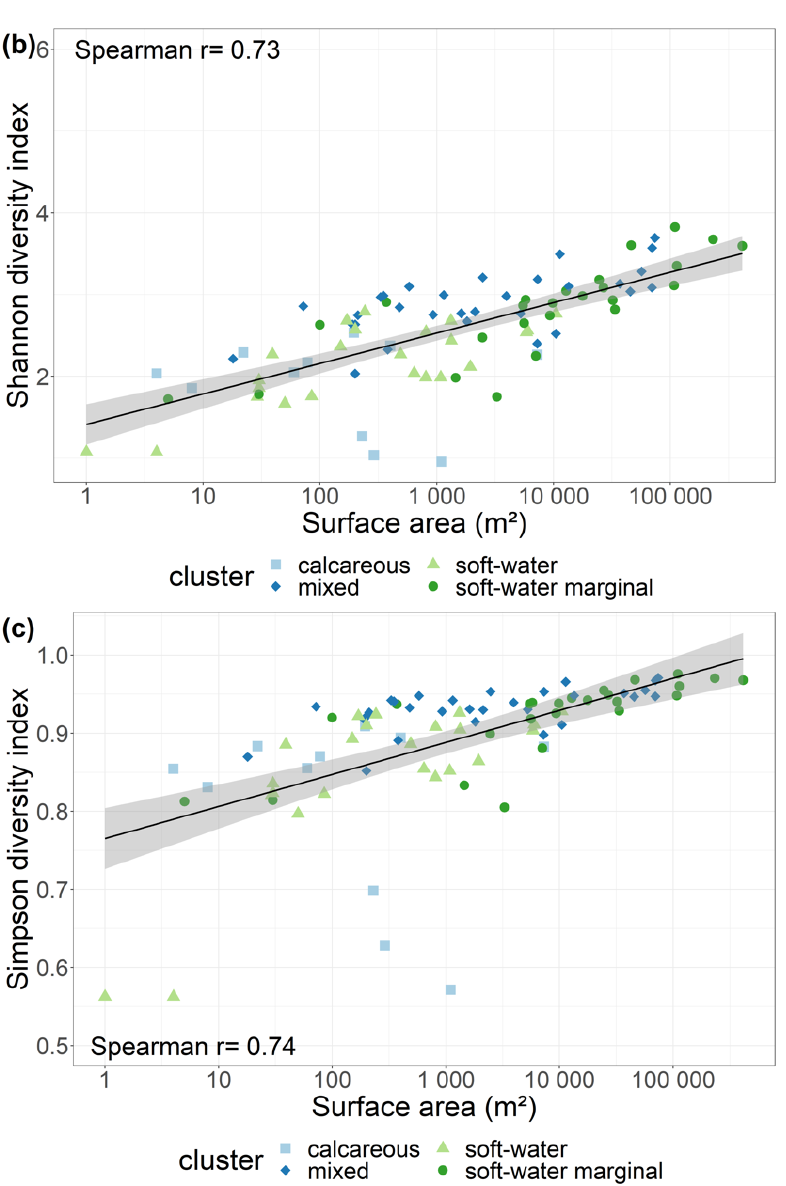
Figure 5. Relationships between the surface area of each SSL and: ( a ) floristic richness, ( b ) Shannon diversity index, and ( c ) Simpson diversity index. Community groups (soft-water, soft-water marginal, mixed, and calcareous) are indicated.